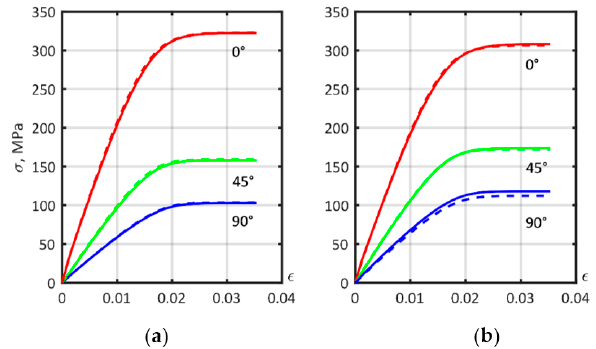
Figure 15. Stress–strain curves of short-fiber reinforced PA6 with 30% carbon fiber were modeled using the exponential law. Comparison between: ( a ) Single AR value and AR distribution; ( b ) Single layer and multilayer analysis.